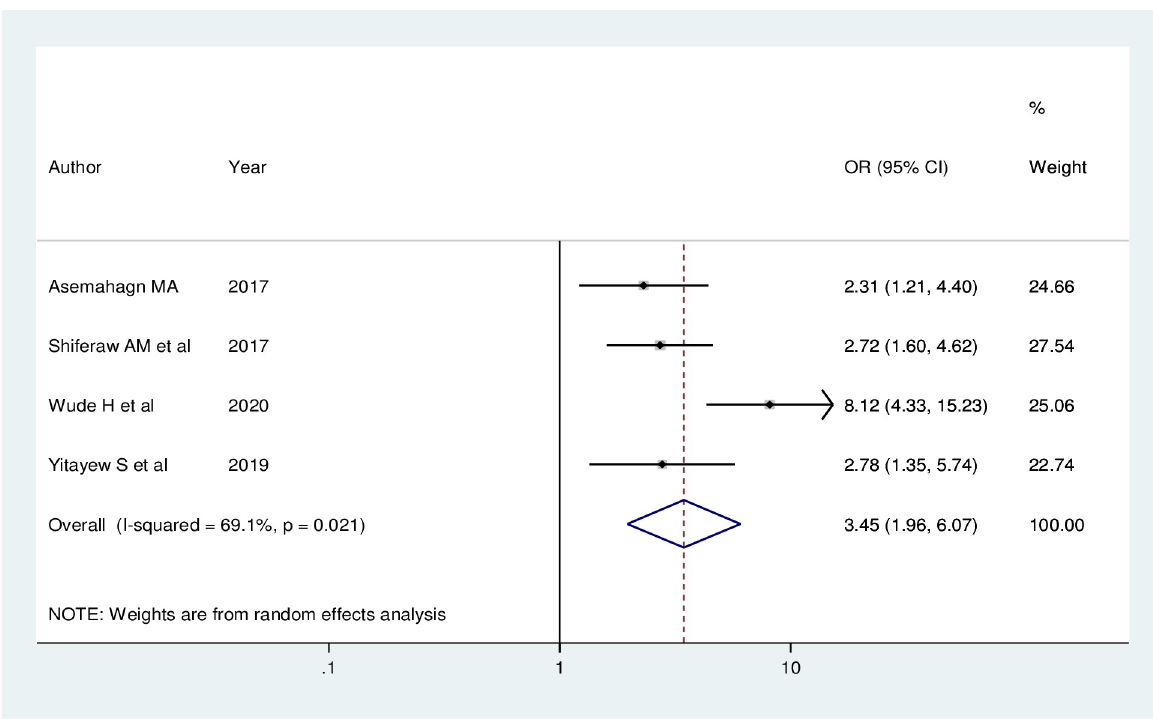
Fig 9. Forest plot showing the pooled odds ratio of the association between training on health information and utilization of routine health information health workers in Ethiopia, 2020.